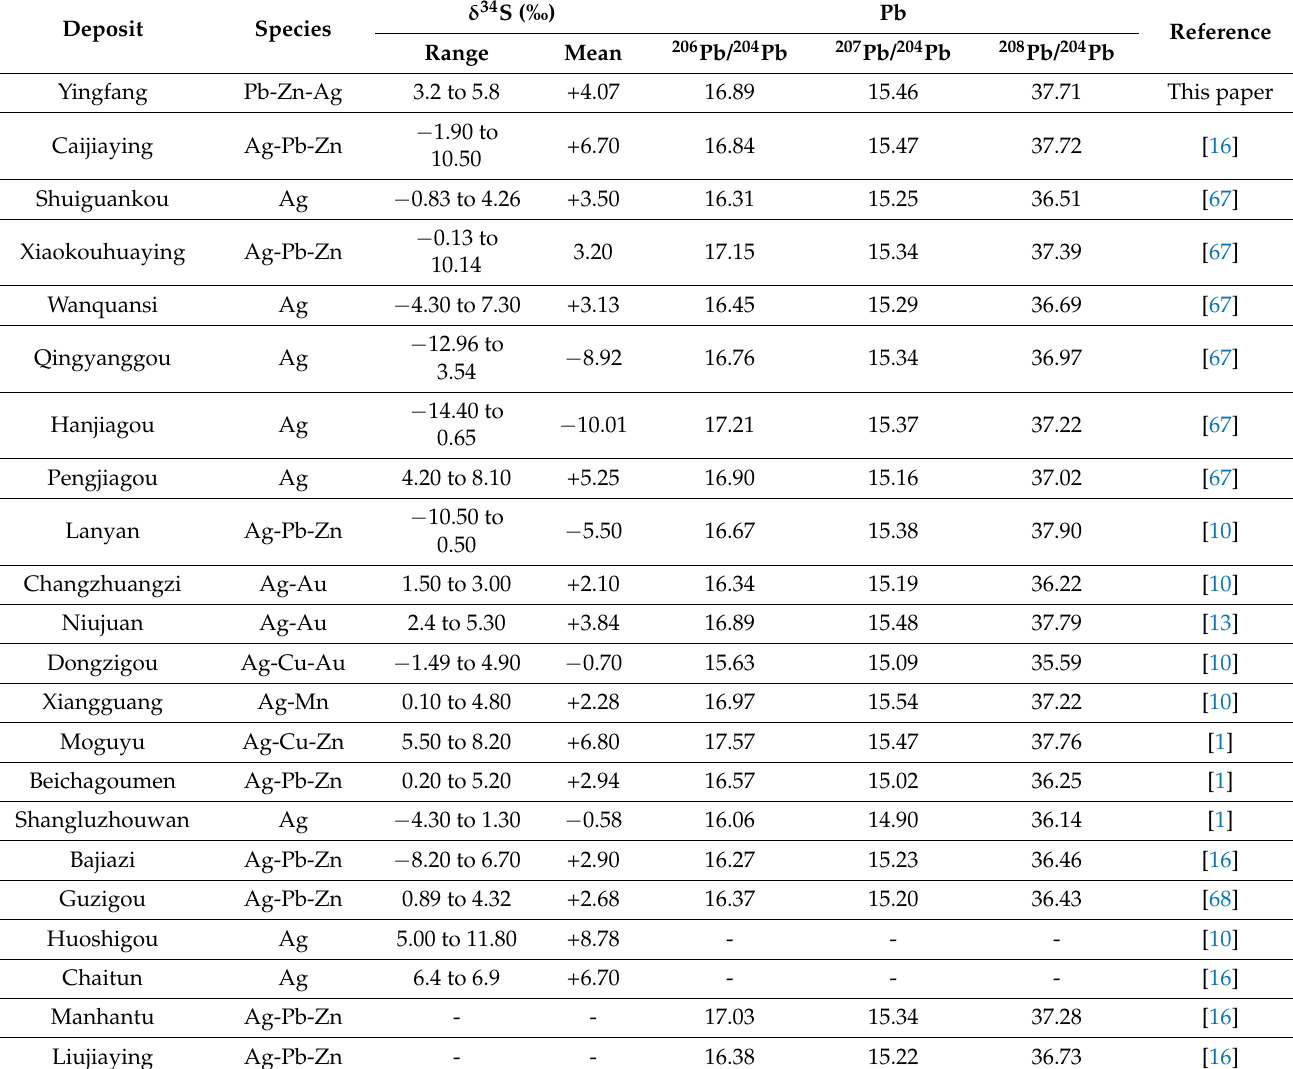
Table 3. Sulfur and lead isotope compositions of the silver-polymetallic deposits in the YLMB.